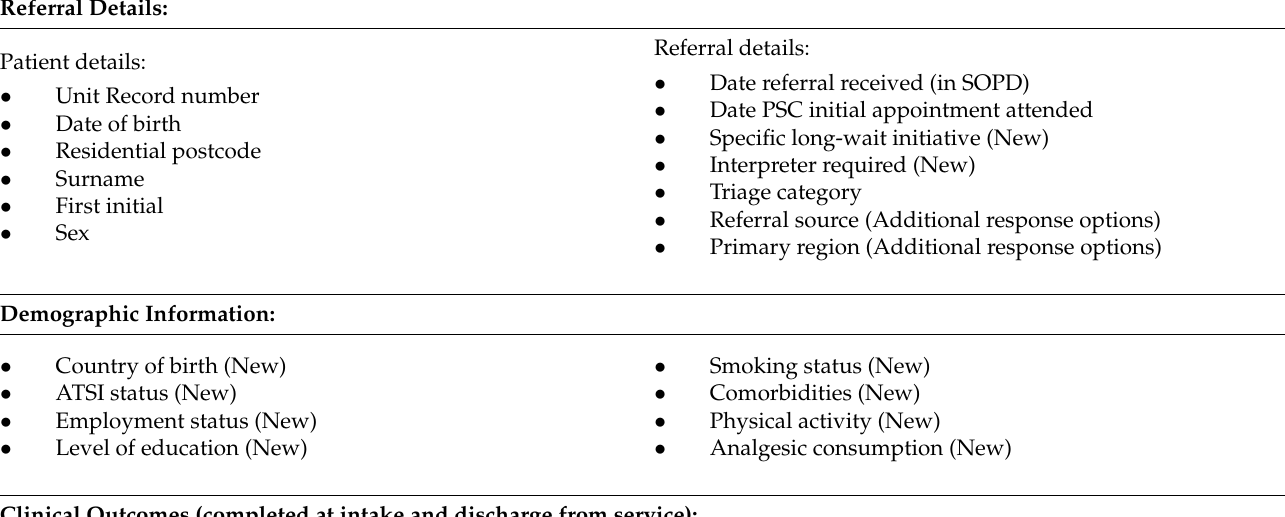
Table A1. Revised standardised data set. New and modified measures, and those where additional response options were added, are